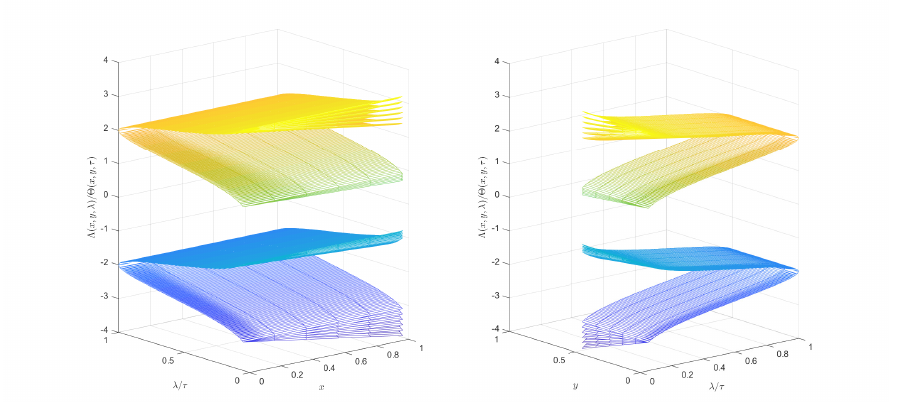
Figure 1. Numerical simulation for fuzzy solutions of (26) with Gaussian fuzzy numbers [ C ] λ =